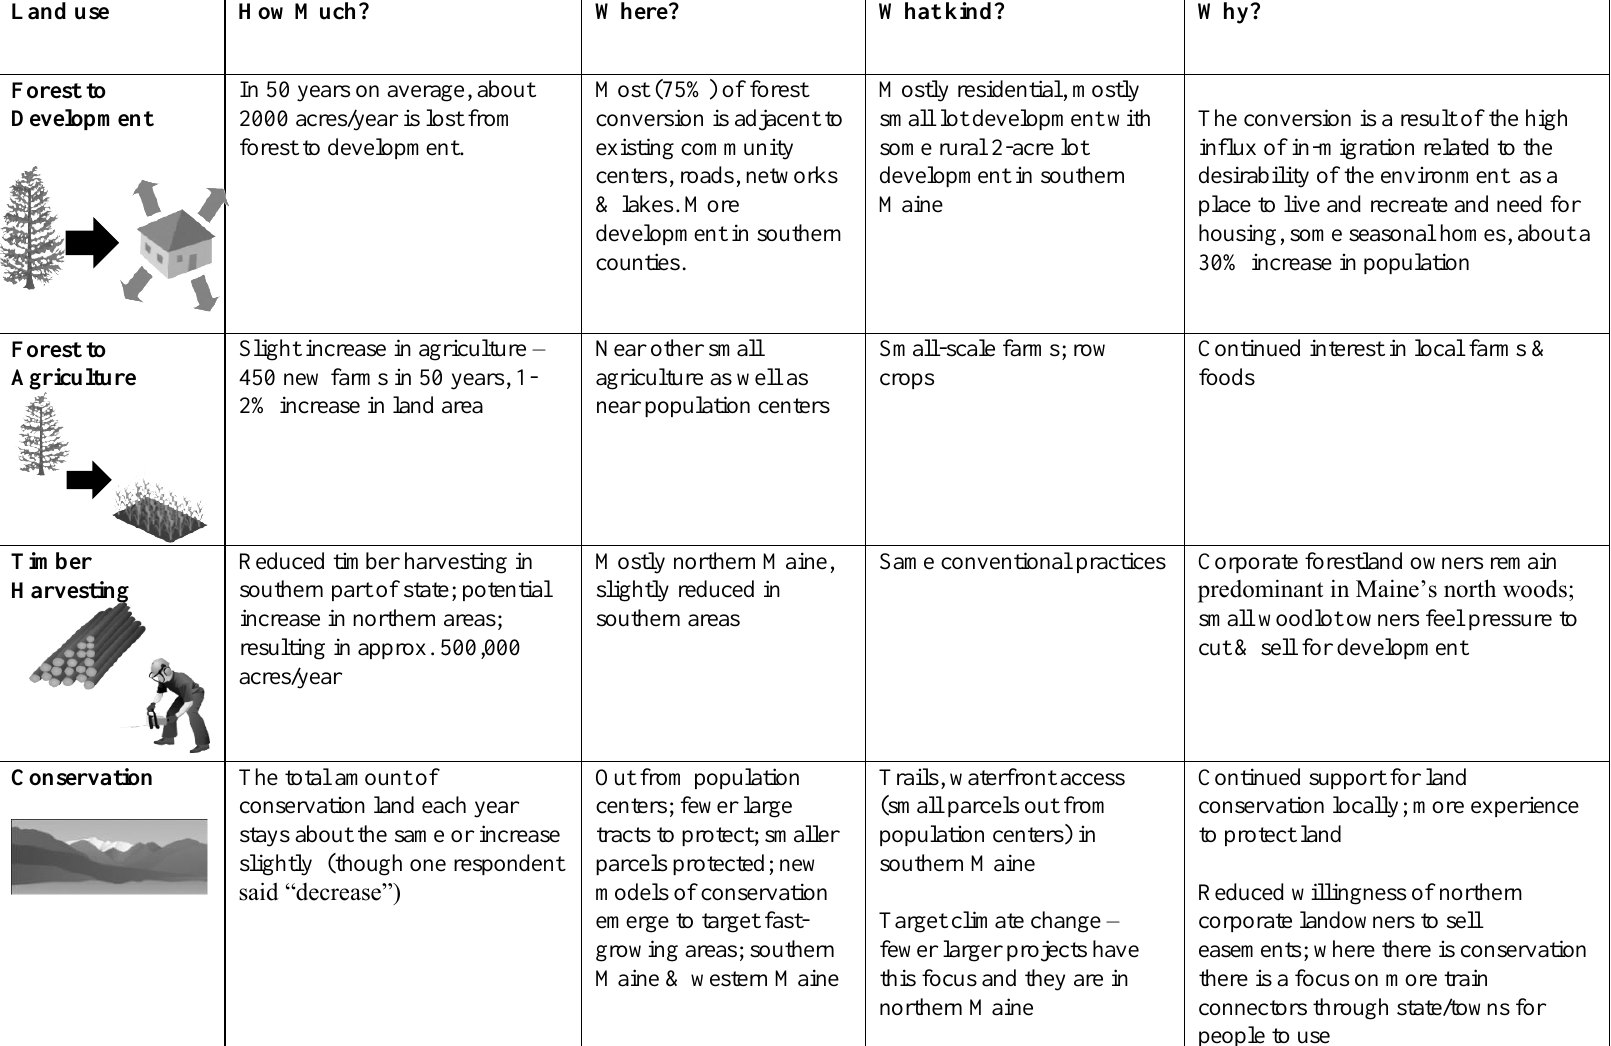
Table A2.9. Scenario 1: “LOTS” More of the Same Land